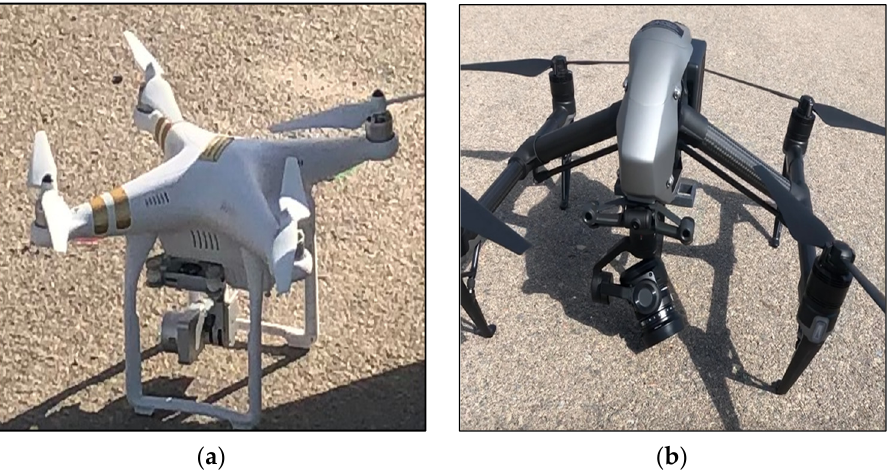
Figure 2. UAVs used in the study: ( a ) Phantom 3 Pro; ( b ) Inspire 2 with a Zenmuse X5S camera. Table 3. Camera and image specifications for the Phantom 3 Pro and Inspire 2 UAV used in the study.